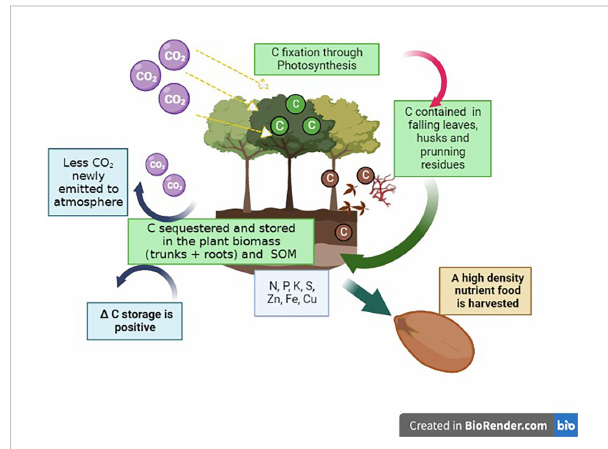
FIGURE 2 Carbon recycling through the pecan agroecosystem and its two main results: positive C balance ( D C storage) and high-density nutrient food. Diagram created in Biorender.com (2022).